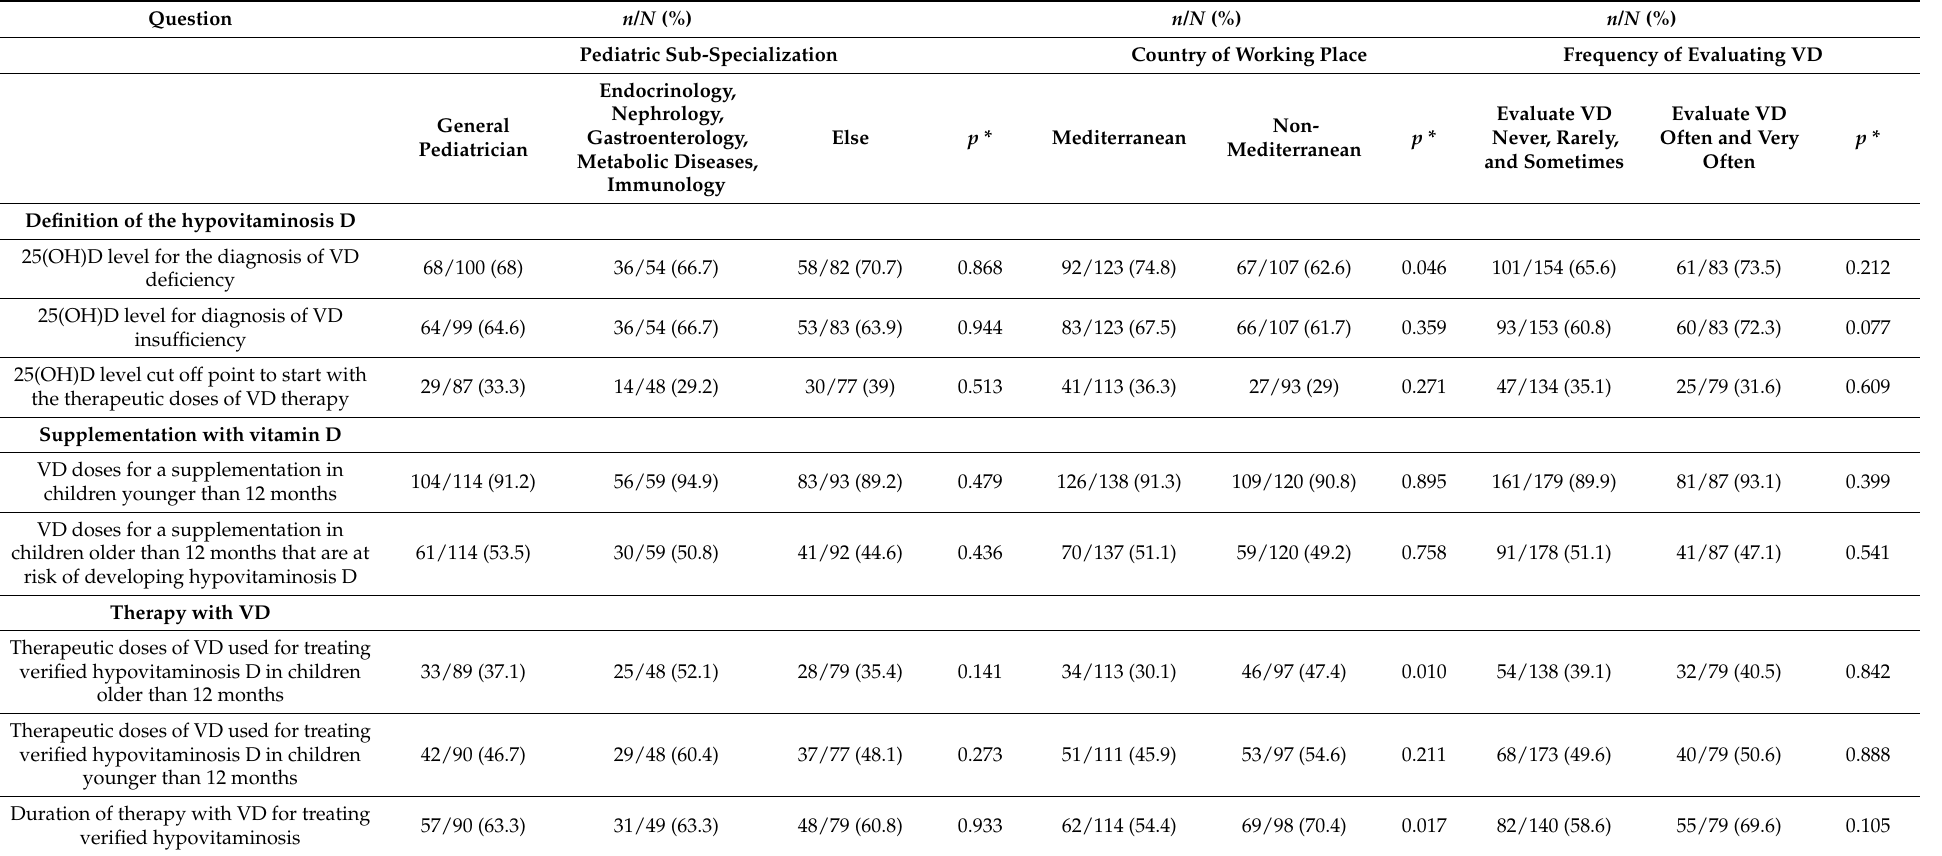
Table 3. Difference between groups in knowledge regarding